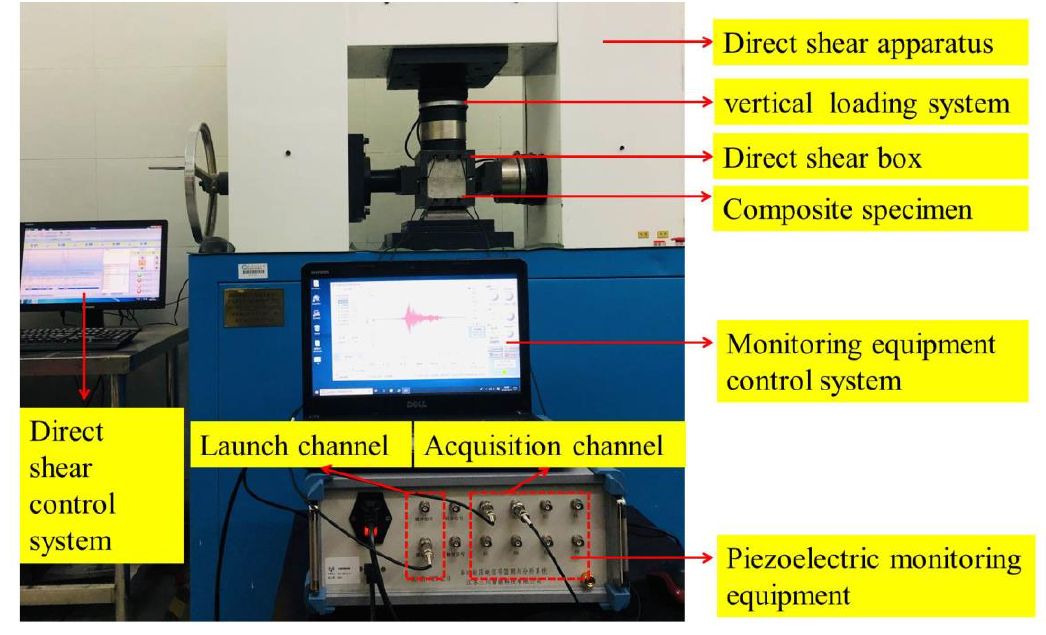
Figure 8. Overall test system.